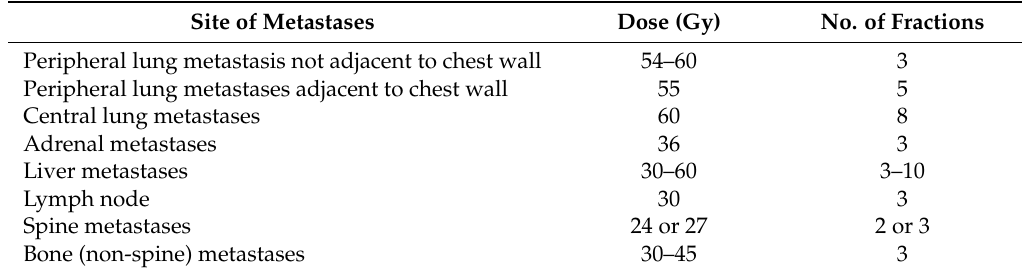
Table 3. SBRT doses used in the treatment of Oligometastatic